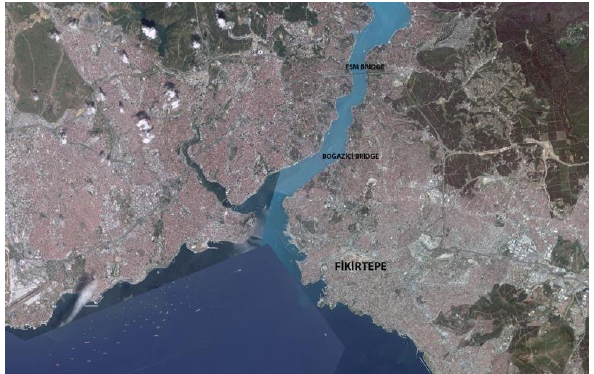
Figure 1: The location of Fikirtepe in Istanbul Fikirtepe, elected as the study site was used as a picnic area until 1950s and after that unplanned